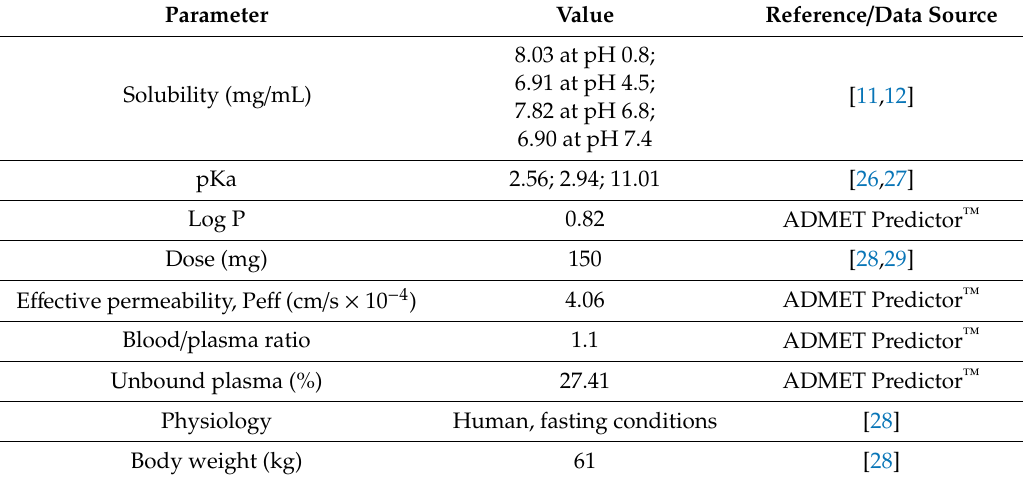
Table 1. Input data used in GastroPlus ™ to simulate plasma